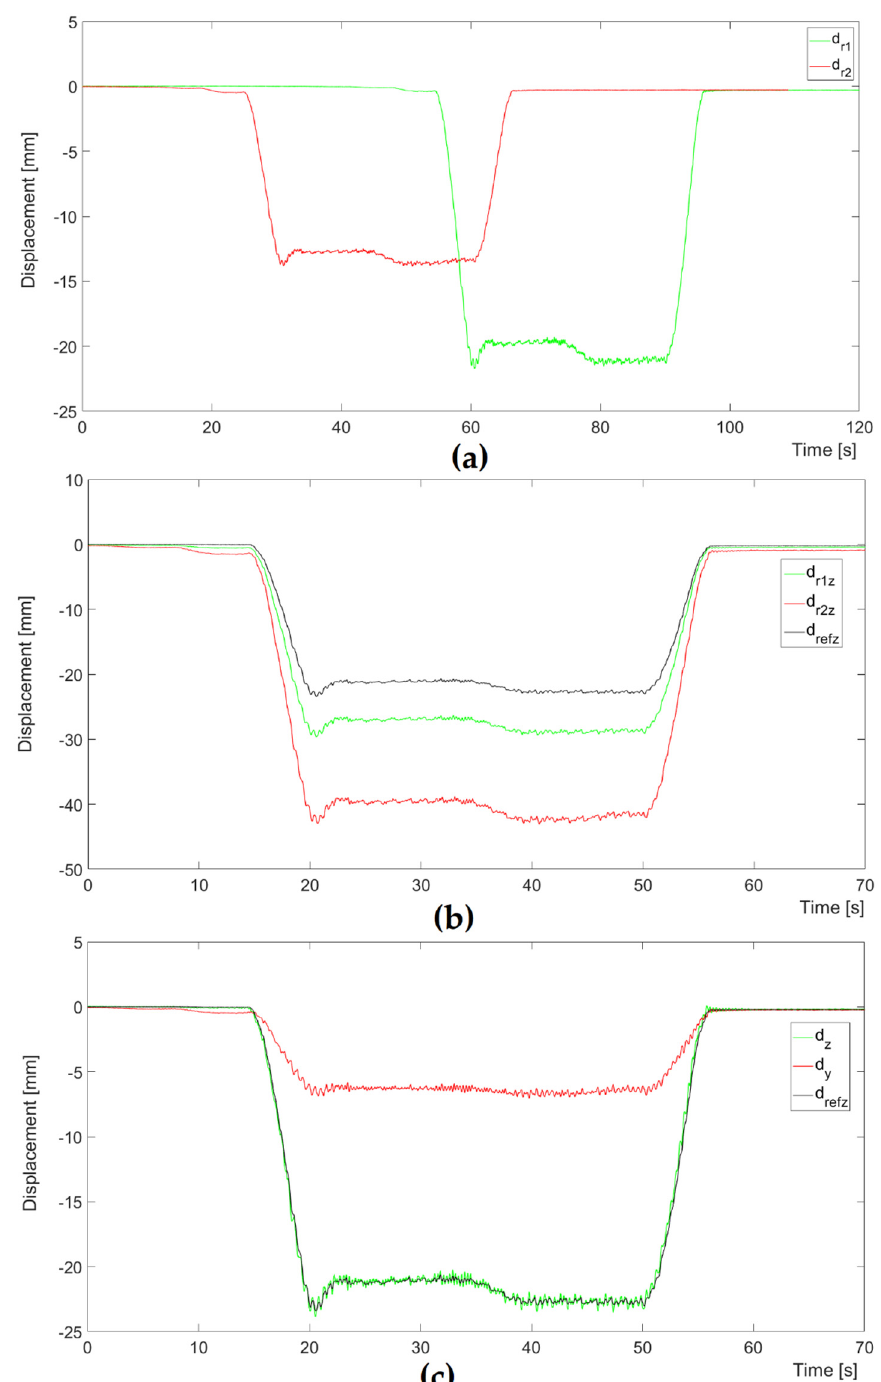
Figure 10. Bridge No. 1—an example of an analysis of a cargo train passage: ( a ) displacements in the range direction measured by single radars No. 1 and No. 2 before synchronization; ( b ) vertical displacement measured by single radars No. 1 and No. 2 and the reference vertical displacement measurement; ( c ) vertical and horizontal displacement calculated based on two radars’ (No. 1 and No. 2) measurements and the reference vertical displacement measurement; scale of the graph ( b ) is two times scale of the graph ( c ).